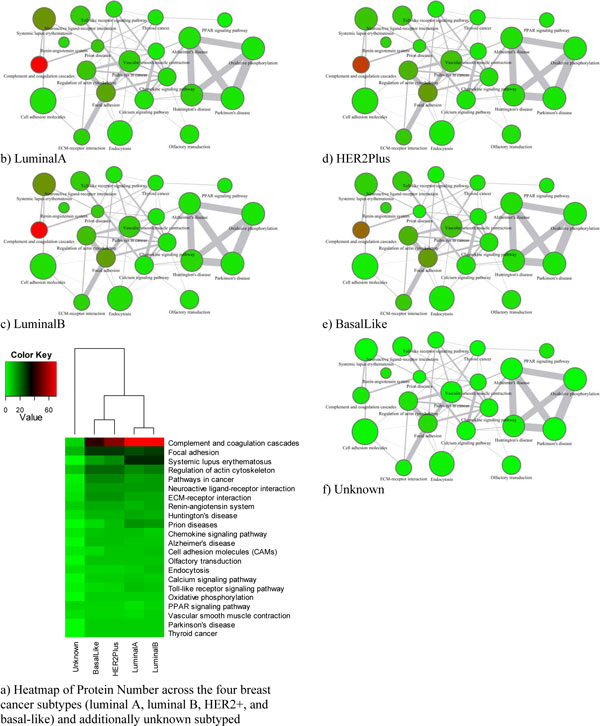
pathway association network. Edge line width is proportional to the connected pathways similarity. Node size is proportional to protein numbers in a pathway. Node color is proportional to the number of proteins with change between each subtype and control in a pathway.